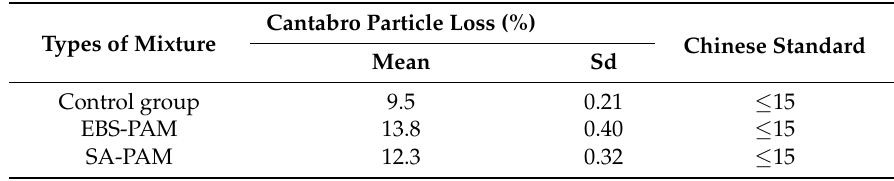
Table 9. Cantabro particle